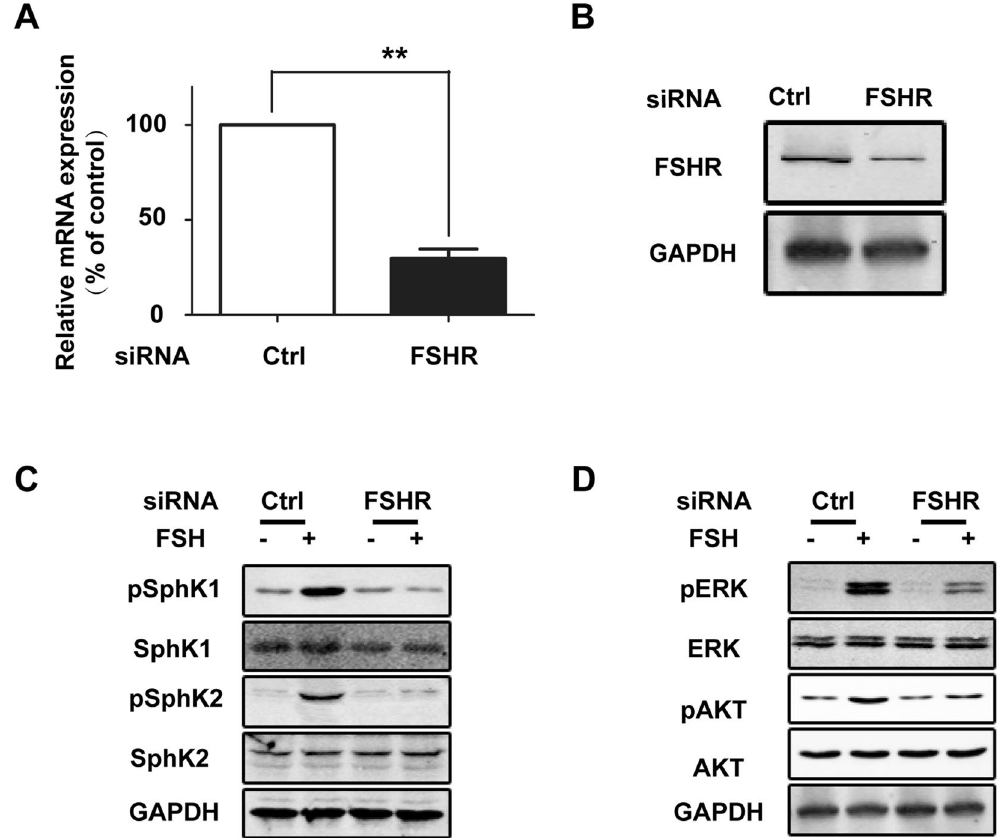
Figure 7. FSHR is required for FSH-mediated SphK activation and Erk/Akt activation in EOC. ( A ) HO8910 cells were transfected with control siRNA and specific siRNA targeting FSHR as indicated. After 24 h of transfection, mRNA levels of FSHR were determined by quantitative RT-PCR. Data are expressed as the change with respect to control siRNA. ( B ) After 48 h of transfection, protein levels of FSHR were determined by Immunoblotting analysis and normalized to GAPDH. ( C ) Having been transfected with the different siRNA, HO8910 cells were cultured with or without FSH (40 mIU/ml). Levels of pSphK1 and pSphK2 were determined by Immunoblotting analysis. Densitometric analysis of pSphK1 and pSphK2 corresponding to the bands were shown in the histogram (normalized to total SphK1 and SphK2). ( D ) Cells transfected with specific siRNA were stimulated with or without FSH (40mIU/ml) for 30 min. Levels of pAkt and pErk were determined by Immunoblotting analysis. Data are mean ± SD. * P < 0.05 vs. control/-FSH; # P < 0.05 vs. control/ +